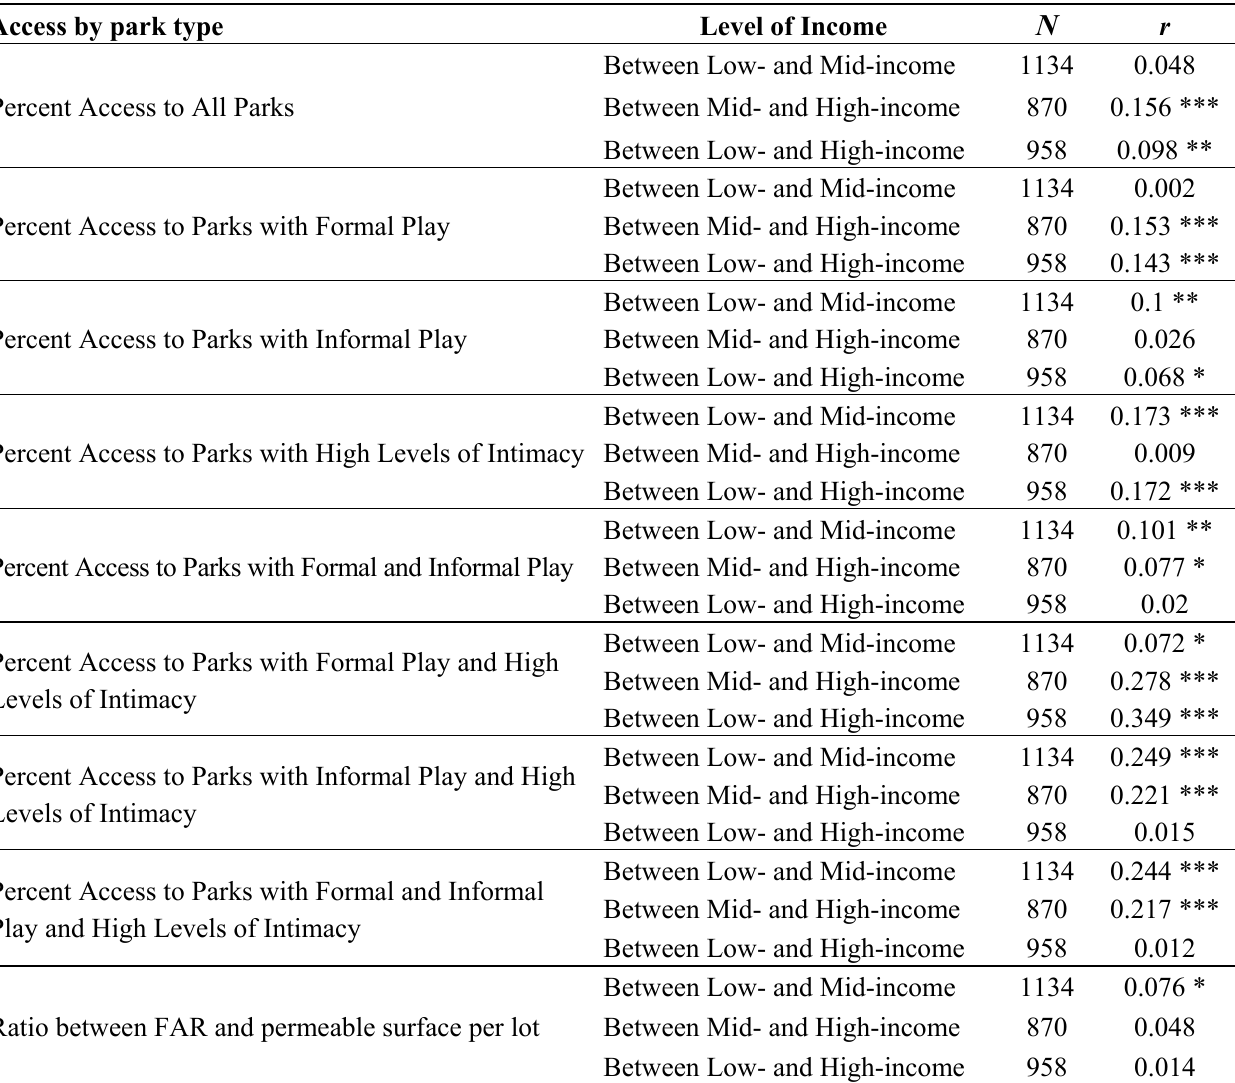
Table 5. Effect sizes (Mann Whitney U Test) between income groups access per park